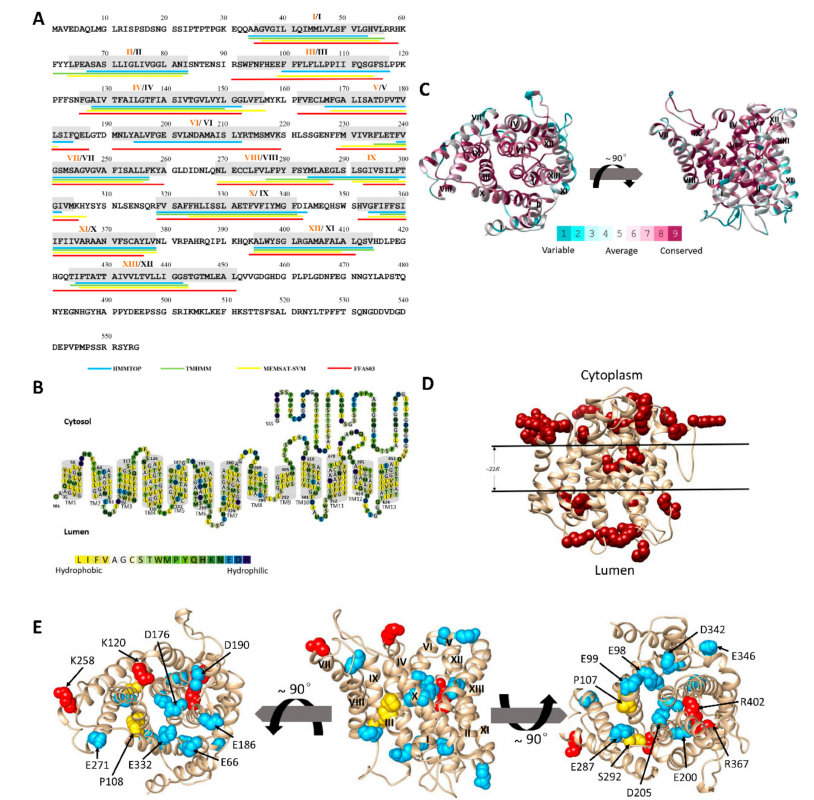
Figure 2. The membrane topology and three-dimensional (3D) model of MnNHX6. ( A ) The transmembrane (TM) segments and topology of the MnNHX6 sequence. The TM helices were predicted by different methods, which are underlined with different colors: HMMTOP with blue, TMHMM with green, MEMSAT-SVM with yellow, and FFAS03 with red. The final TM helix assignments are highlighted in gray, and the numbers of final TM helices are displayed in orange Roman numerals. The other TM helix predications of the endosomal-type NHXs are displayed in black Roman numerals based on the amino acid sequence alignment of AtNHX1. The differences between the two boundaries of endosomal-type NHXs are discussed in the main text. ( B ) The suggested TM topology of MnNHX6. Residues are colored according the hydrophobicity scale of Kessel and Ben-Tal [27]. Overall, the TM helices of MnNHX6 are hydrophobic, but they do feature polar and titratable residues. ( C ) The MnNHX6 model structure was supported by evolutionary conservation. Top and side views of a model structure of the membrane domain of MnNHX6 based on the structure of MjNhaP1 and colored according to the degree of ConSurf conservation. ( D ) The MnNHX6 model follows the ‘positive-inside’ rule. The lysine and arginine residues in the MnNHX6 model are shown as dark red spheres. The approximate boundaries of the hydrocarbon regions of the membrane are shown in black. ( E ) Experimental validation of the MnNHX6 model using structure-guided mutations. The site-directed mutagenesis of MnNHX6 is shown in Table S1. The distribution of these residues is shown in the MnNHX6 model. The conserved structure-related residues, and the negatively and positively charged residues, in the MnNHX6 model are shown as yellow, blue, and red spheres, respectively. Left side; a top view from the cytoplasmic side of the membrane. Middle; a side view parallel to the membrane with the cytoplasmic side facing upward and the TM segments numbered. Right side; a view from the luminal